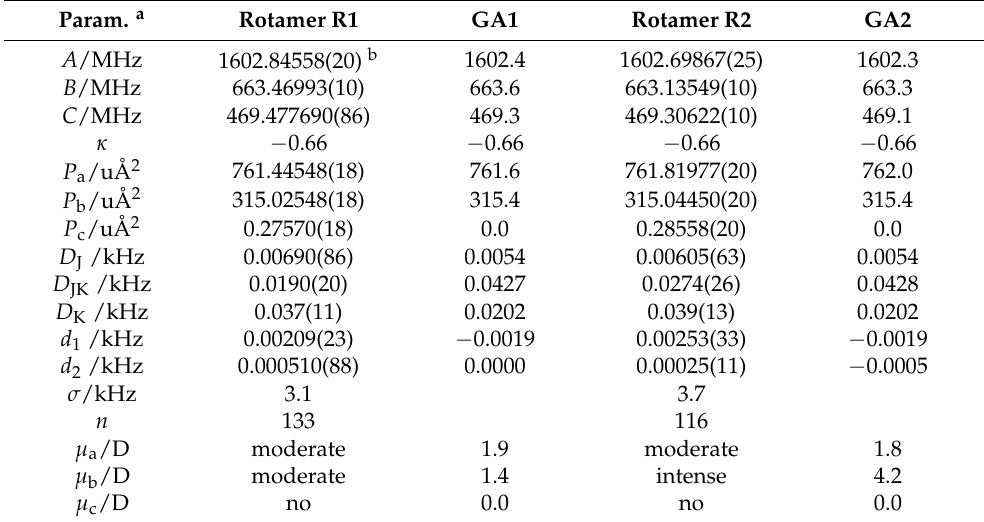
Table 1. Rotational parameters obtained from the analysis of the spectrum of the two conformers of GA and its comparison with the DFT values (B3LYP-GD3/6-311++G(2d,p)) for the identified forms. Param. a Rotamer R1